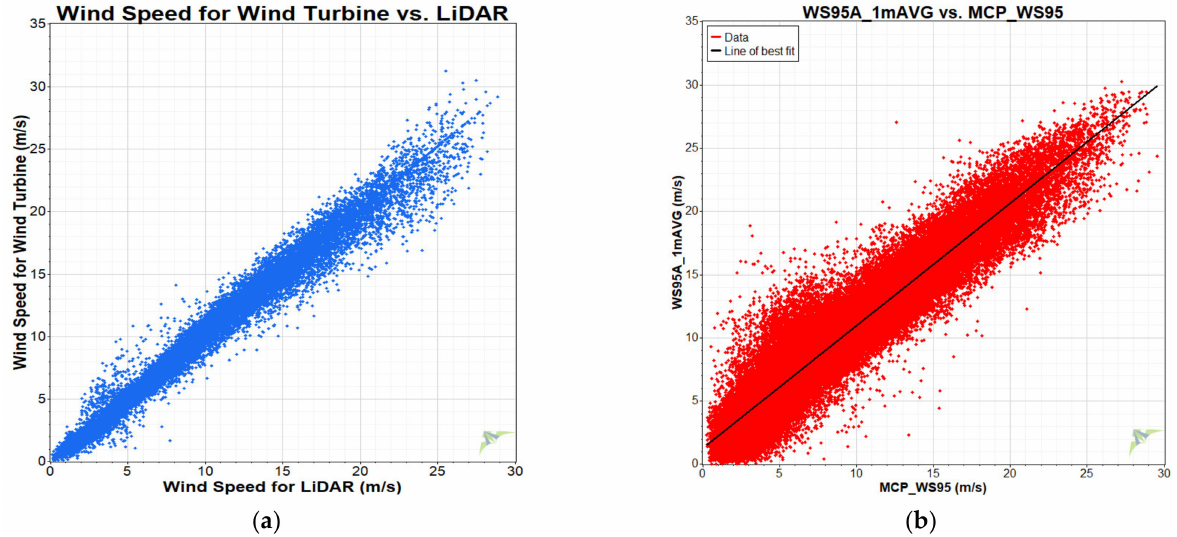
Figure 11. ( a ) Wind speed for wind turbine (hub) and LiDAR (MCP); ( b ) wind speed for offshore met mast and nearshore LiDAR